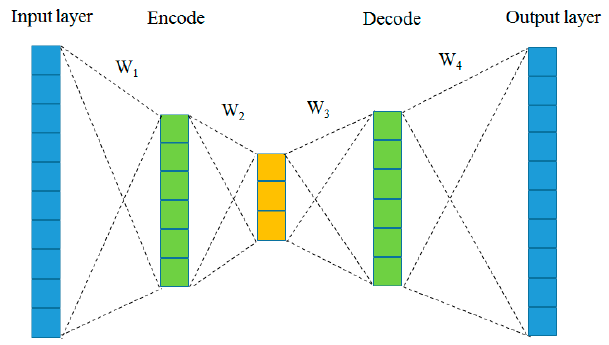
Figure 2. Schematic of DAE neural network.